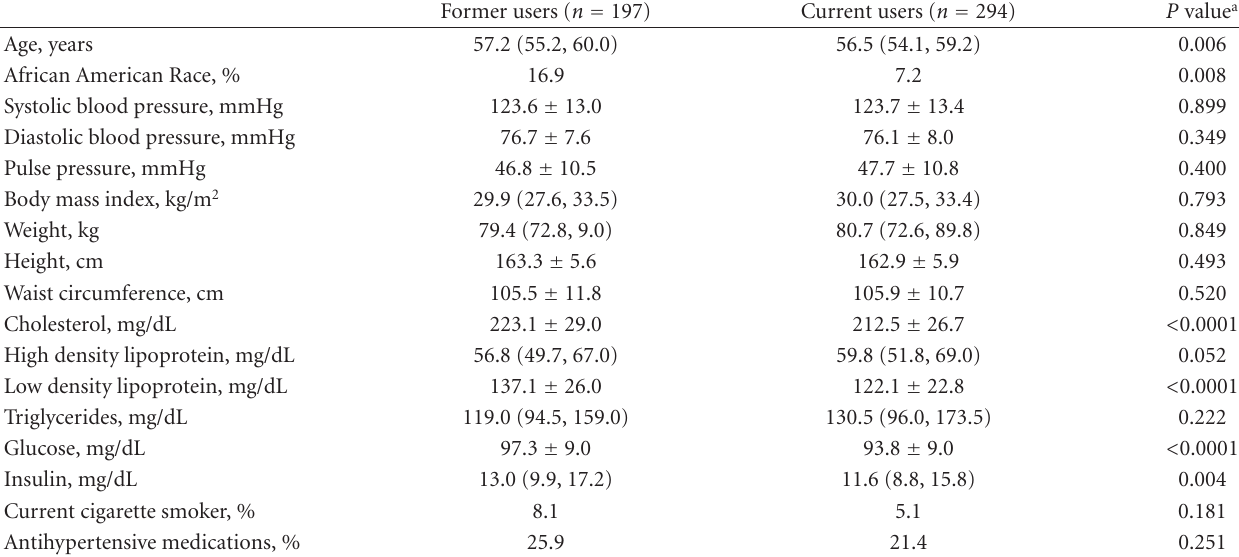
Table 1: Demographic, anthropometric and health characteristics by hormone therapy use.